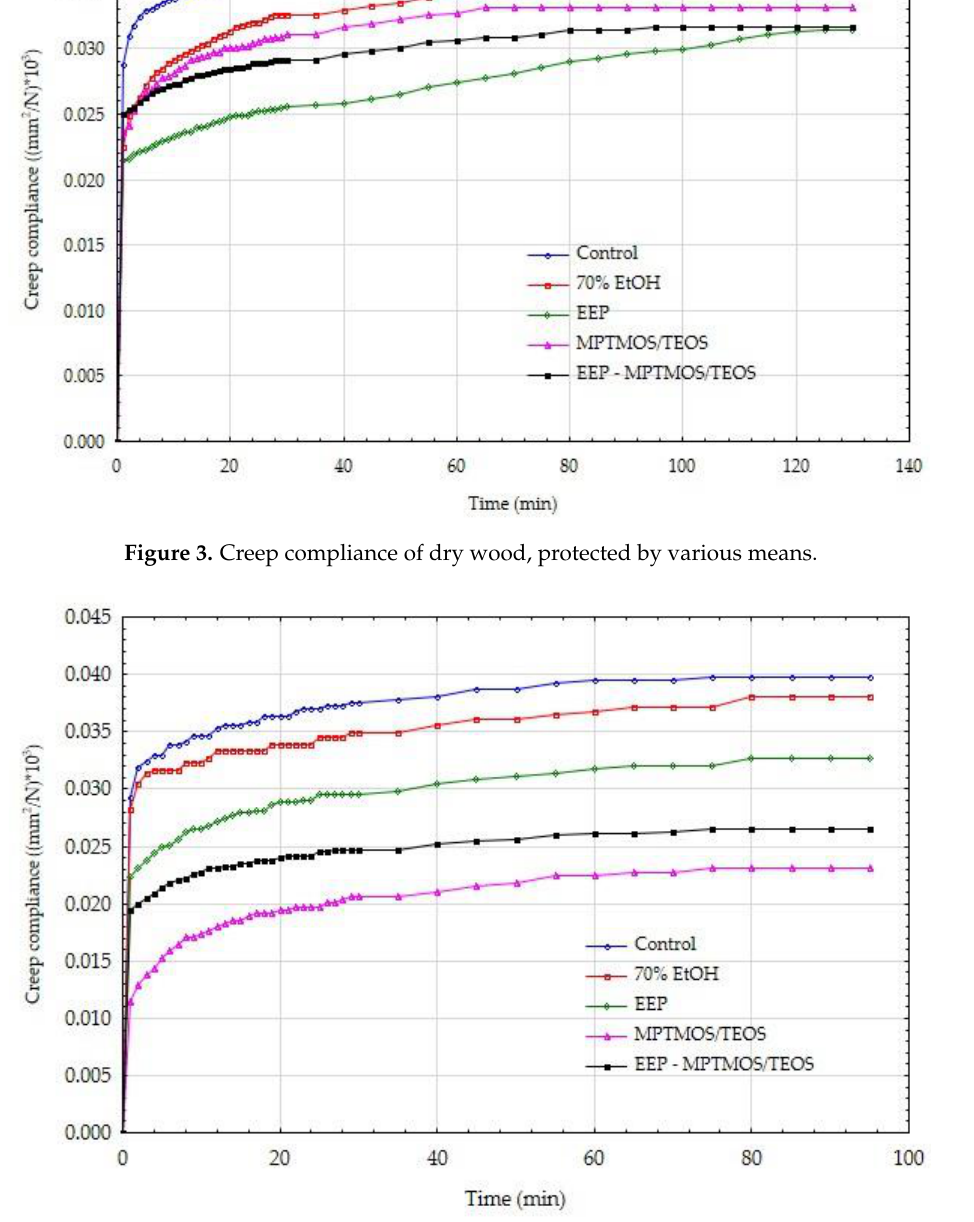
Figure 4. Creep compliance of wet wood, protected by various means.